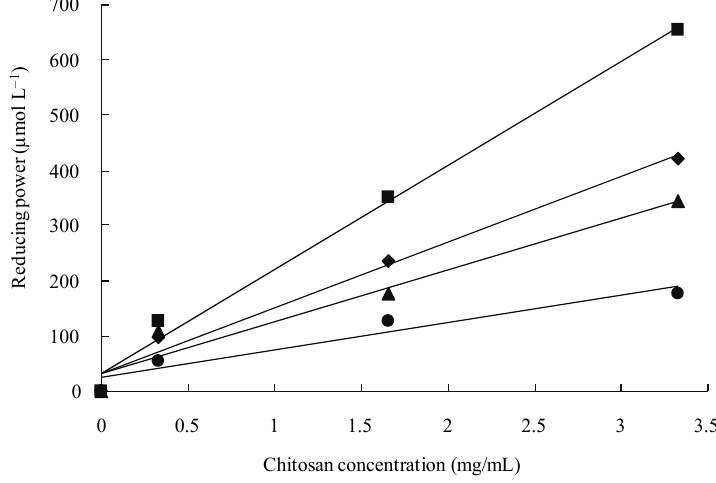
Figure 3. Reducing power of different LMW chitosans in the TPAC test. CS1 ( ♦ ), CS2 ( ■ ), CS3 ( ▲ ), and CS4 ( ● ).